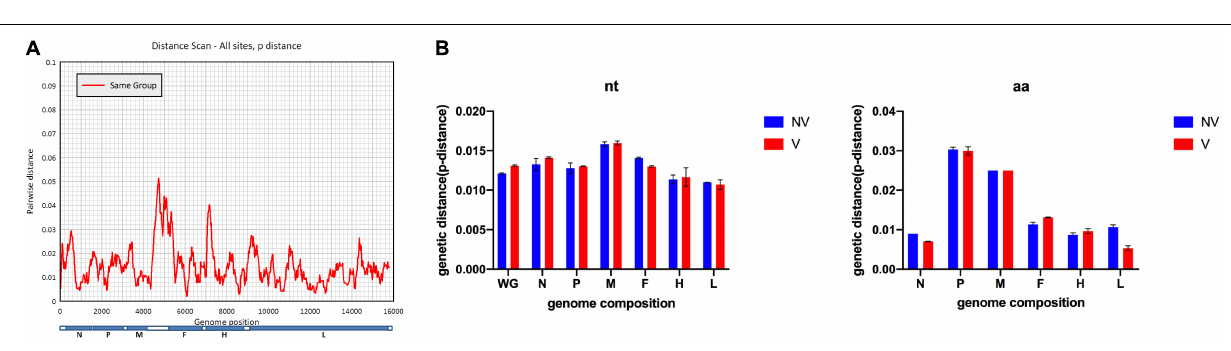
values. The genotyping result of the H gene ( Figure 1B ) was consistent with the